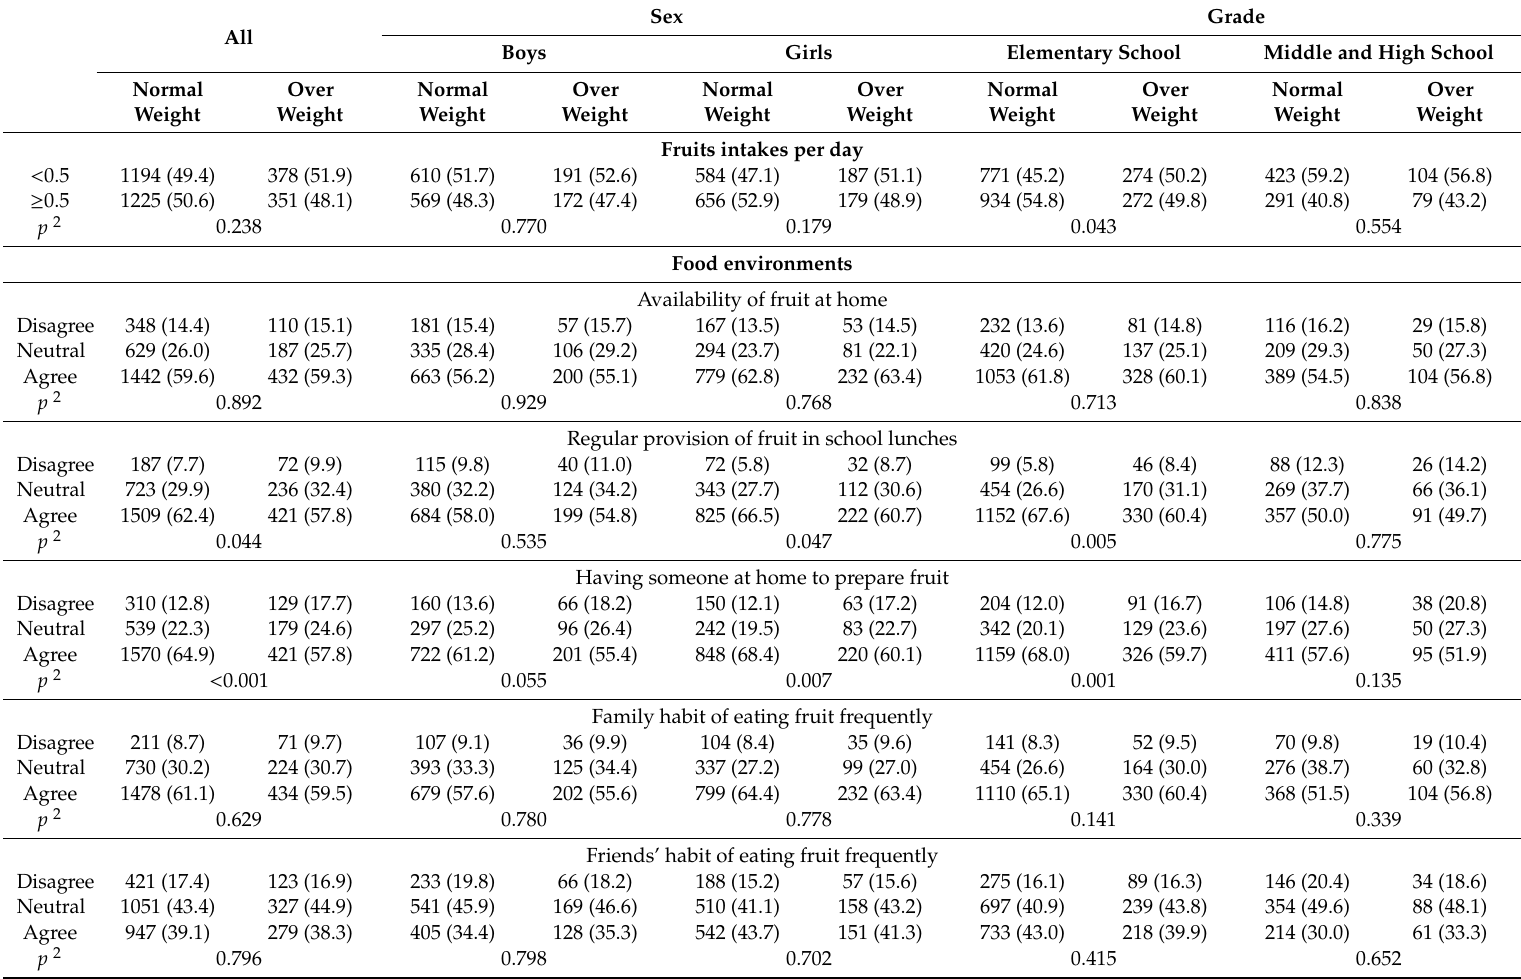
Table 4. Relationship between aspects of participants’ food environments, frequency of fruit intakes, and weight status 1